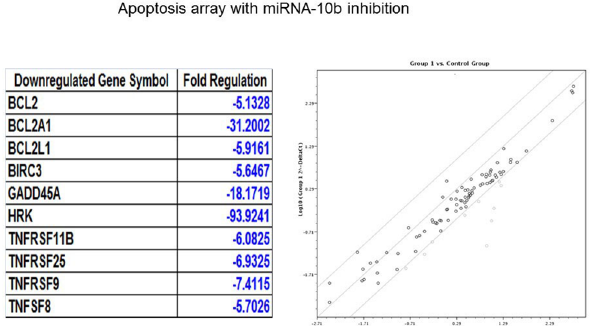
Fig 3. Anti-apoptotic BCL2 family members are downregulated by inhibition of miRNA-10b. (A) A human apoptosis array was used for the identification of apoptotic genes influenced by the inhibition of miRNA-10b. Total RNA was extracted from DAOY cells transfected with anti-miRNA-10b, and then subjected to RT-PCR for the analyses of apoptotic genes. The pale grey in the figure at right references the genes identified in the table at left. (B) Medulloblastoma cells were transfected with control miRNA, anti-miRNA-10b or miRNA-10b mimic. Lysates of transfected cells were subjected to Western blotting using (A) anti-BCL2 antibody (B) anti-MCL1 antibody. β -actin was used as a loading